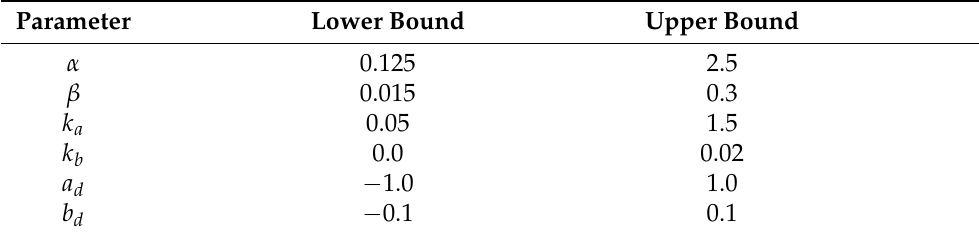
Table 2. The boundaries per model parameter defined for the